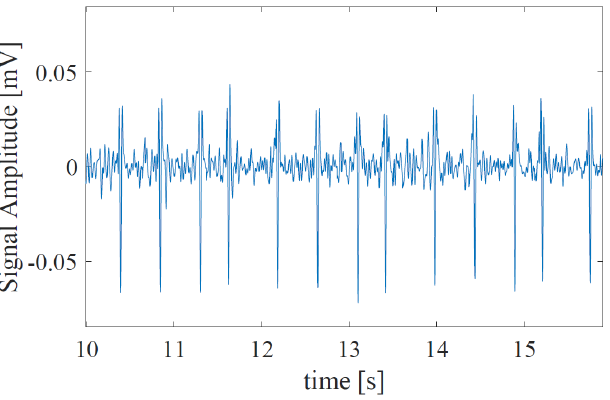
Figure 2. The part of the extracted FECG from AECG when the signal accuracy is relatively good.